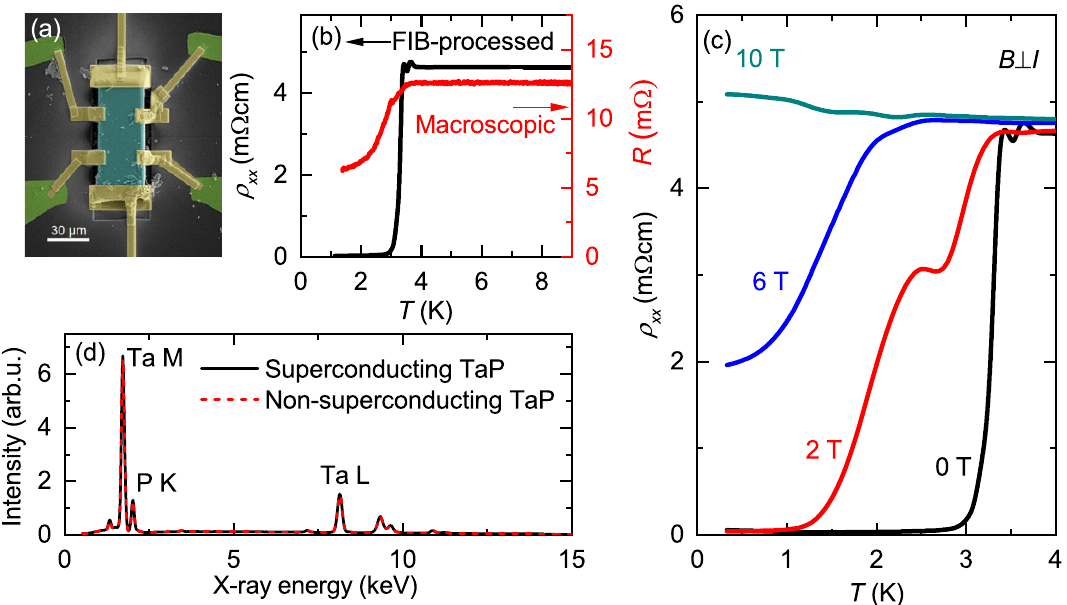
Figure 1. ( a ) False color SEM image of a typical FIB contacted crystal. ( b ) Temperature sweeps showing the resistive transition of the FIB-processed sample 4 and the macroscopic crystal from which all FIB samples were cut. ( c ) Resistivity curves at low temperature of FIB-processed sample 4, under different, constant magnetic fields perpendicular to the current direction. ( d ) EDX spectra of the bulk sample used in our experiments and a non-superconducting sample obtained from a different source. Within the resolution, the compositions are the